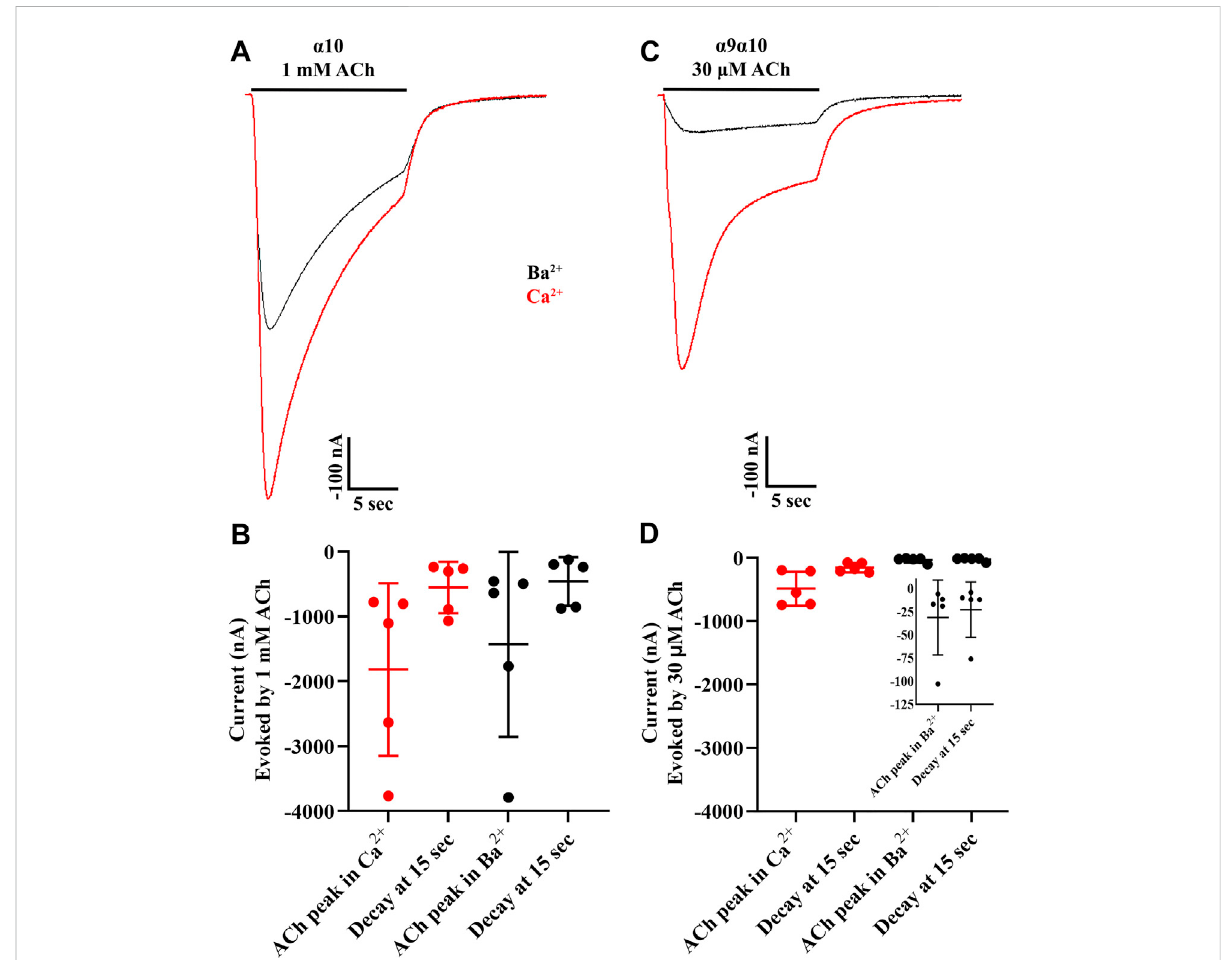
FIGURE 10 Acetylcholine-evoked currents from human homomeric α 10 nAChRs desensitize faster relative to those from human α 9 α 10 nAChRs. X. laevis oocytes were injected with cRNA encoding human α 10 subunits and incubated in frog saline containing STR (20 μ M) or with cRNAs for α 9 plus α 10 subunits, incubated in saline only, and subjected to voltage-clamp electrophysiology after 3 days. (A) Current traces from α 10 nAChRs showing theresponsetoa15 spulseofAChinthepresenceofcalcium(red)comparedtobarium(black). (B) Thepeakcurrentamplitudesinresponseto ACh were − 1,818 ± 1,329 nA (n = 5) in the presence of calcium and − 1,430 ± 1,424 nA (n = 5) in the presence of barium. The responses decayed to − 553 ± 396 nA or 31 ± 6% (n = 5) of peak amplitude at the end of the 15 s pulse of ACh in the presence of calcium. The responses decayed to − 459 ± 375 nA or 35 ± 11% (n = 5) of peak amplitude at the end of the 15 s pulse of ACh in the presence of barium. (C) Current traces from α 9 α 10 nAChRs showing the response to a 15 s pulse of ACh in the presence of calcium (red) compared to barium (black). (D) The peak current amplitudes in response to ACh were − 484 ± 270 nA (n = 5) in the presence of calcium and − 31 ± 40 nA (n = 5) in the presence of barium.